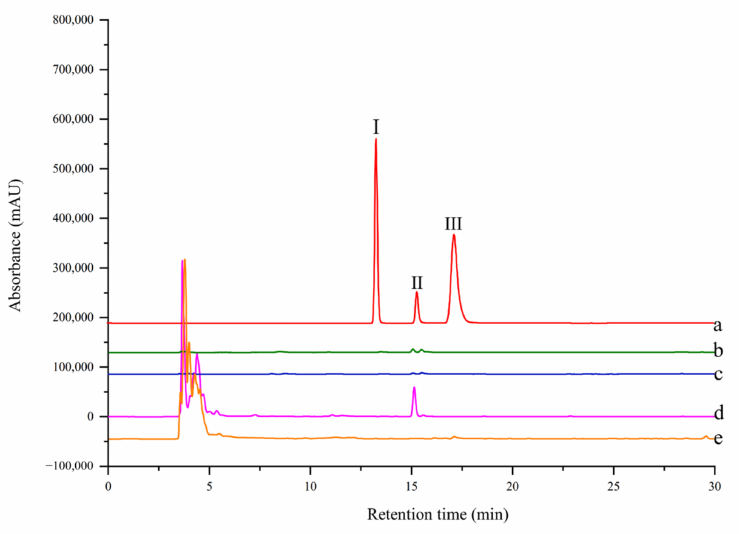
Figure 5. HPLC chromatogram from a model mixture before and after ligand fishing (a) the model mixture: two non-binders (0.05 mg/mL 4-hydroxycinnamic (I) and 0.05 mg/mL coumarin (III)) and one binder (0.05 mg/mL rutin (II)). (b) the compounds obtained by ligand fishing using MNPs- PTP1B. (c) the compounds obtained by ligand fishing using MNPs. (d) the compounds obtained by ligand fishing using EC-PTP1B. (e) the compounds obtained by ligand fishing using control cells ( E. coli cells expressing only ice nuclein protein).